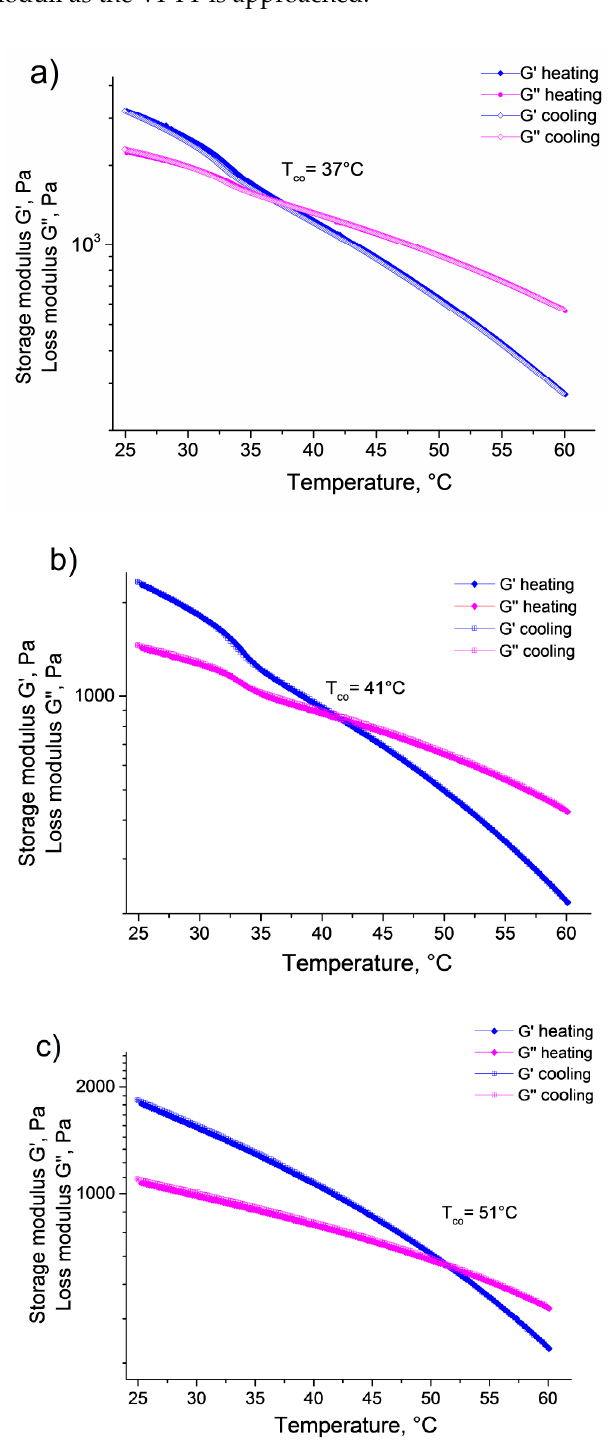
Figure 4. Evolution of storage G’ and loss G” moduli of supramolecular gels under heating and cooling temperature ramps (temperature change rate = 2 °C/min, f = 10 Hz, γ = 0.1%) for ( a ) G3 ; ( b ) G5 ; ( c ) R3 hydrogel samples.